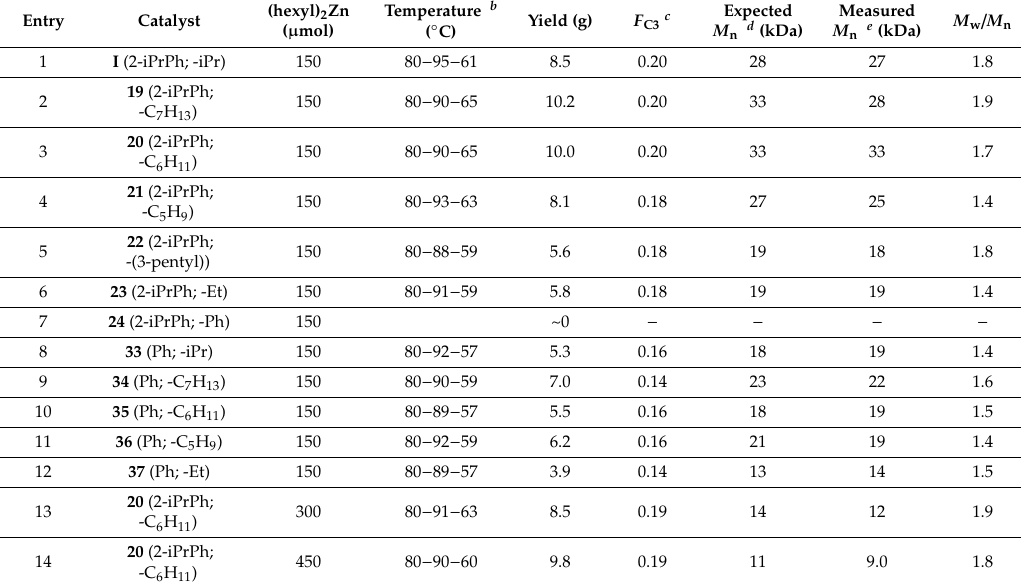
Table 2. Polymerization results